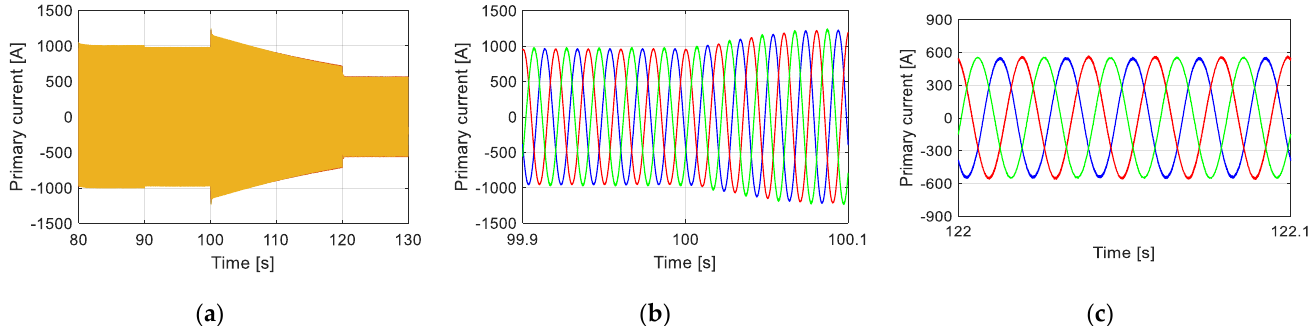
Figure 18. ( a ) Primary current response to reference-speed-dependent load variations (target I); ( b ) transient response of the primary current; ( c ) steady state of the primary current.